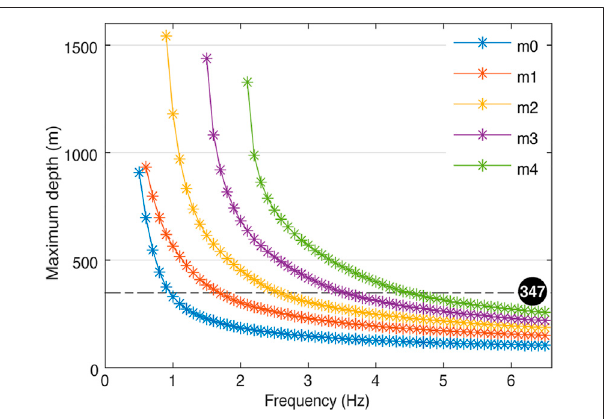
FIGURE 9 | The maximum constrained depth obtained from the given threshold of the sensitivity kernel for each mode, where m0 – m4 denote the fundamental to fourth-higher-order